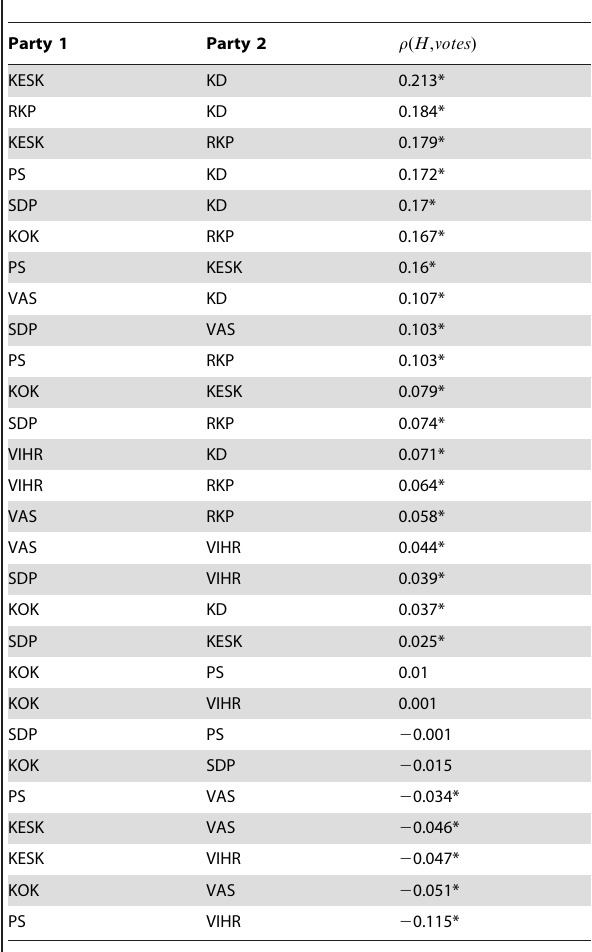
Table 6. Correlation between the number of common answers N ca and the geometric mean of votes of pairs of candidates belonging to different